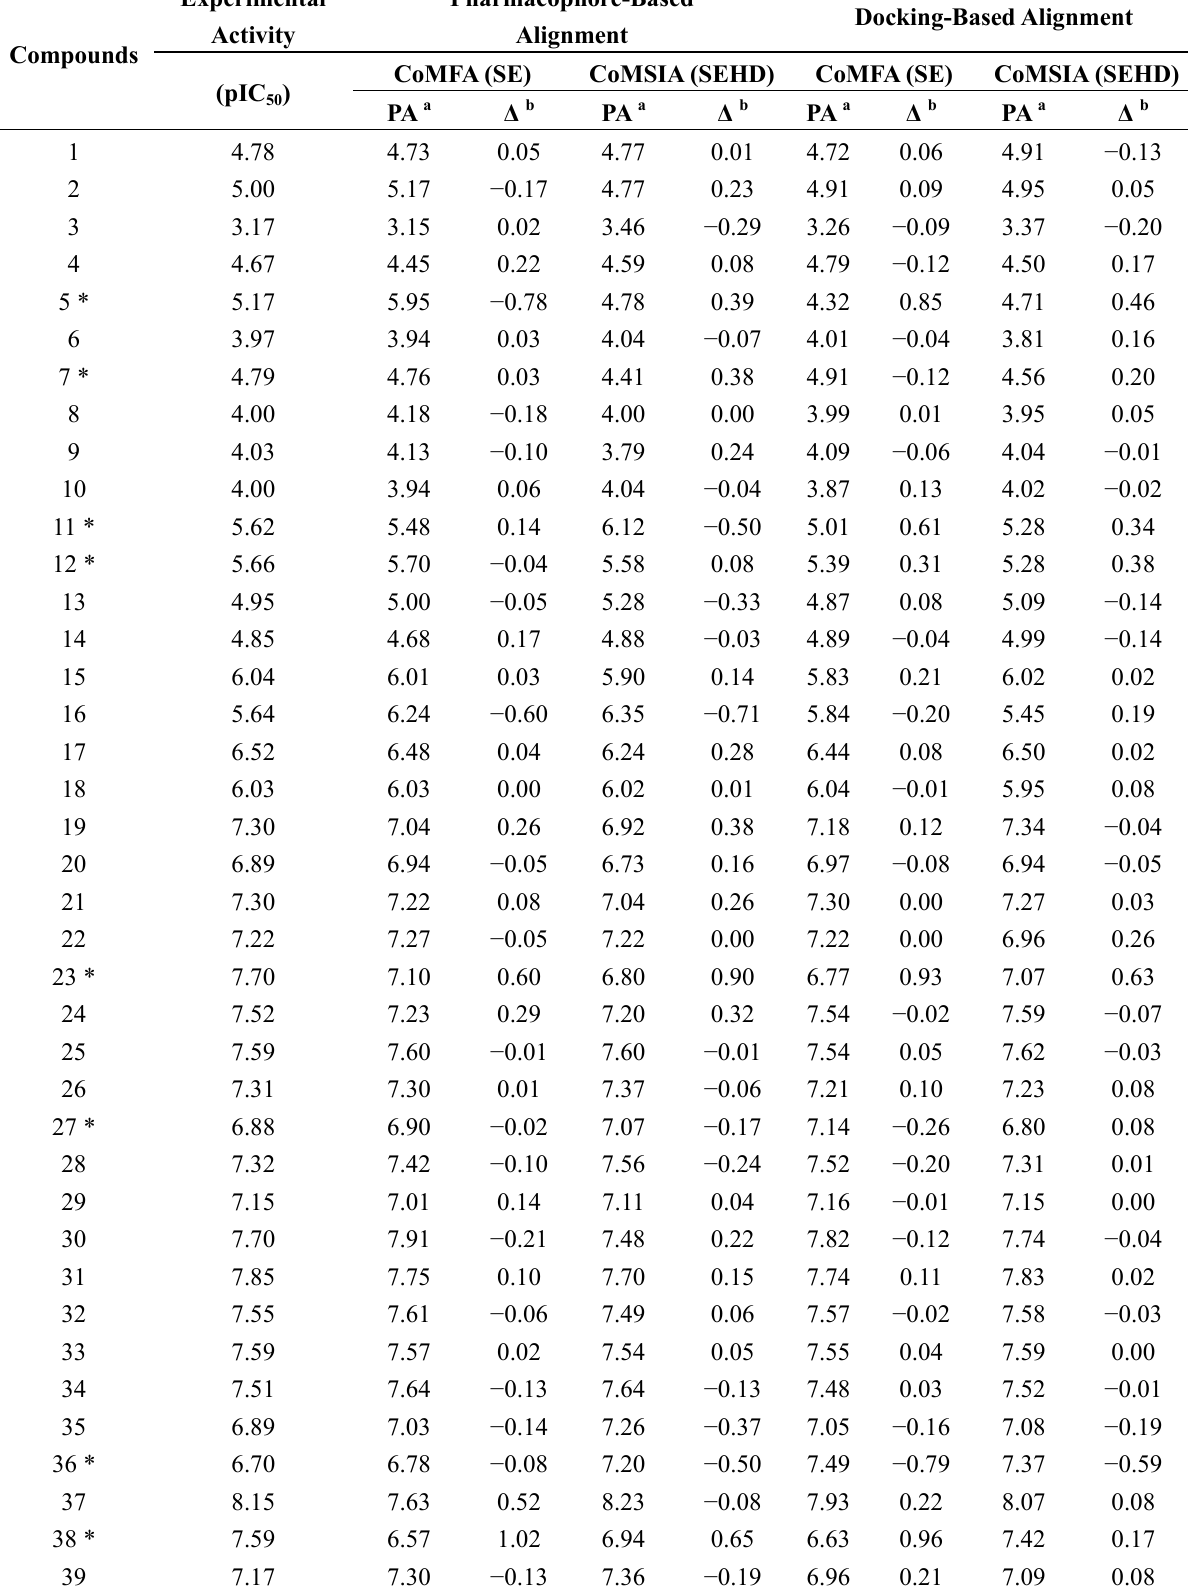
Table 3. Experimental, predicted and residuals of pIC in the training and test sets from the best selected three-dimensional quantitative structure-activity relationship (3D-QSAR)